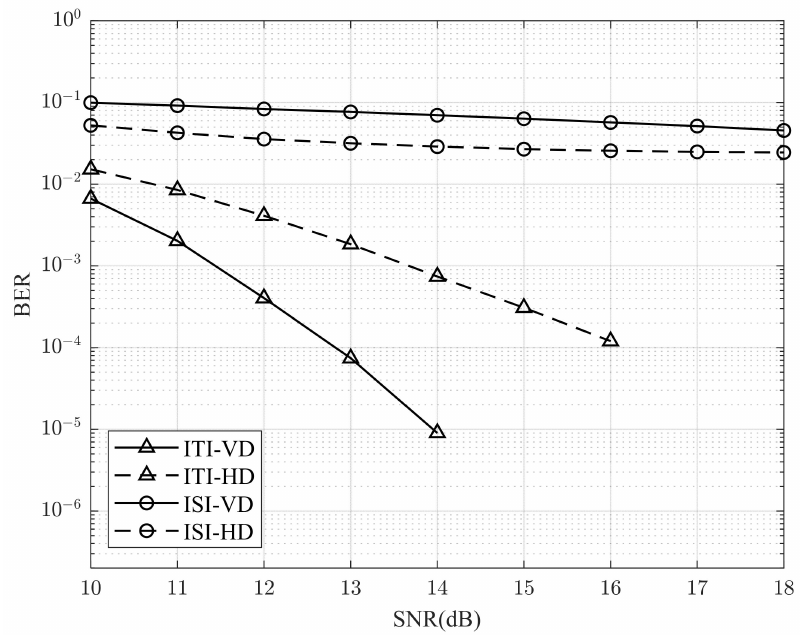
Figure 3. BER performance of the four combinations of the estimator and detection structures.